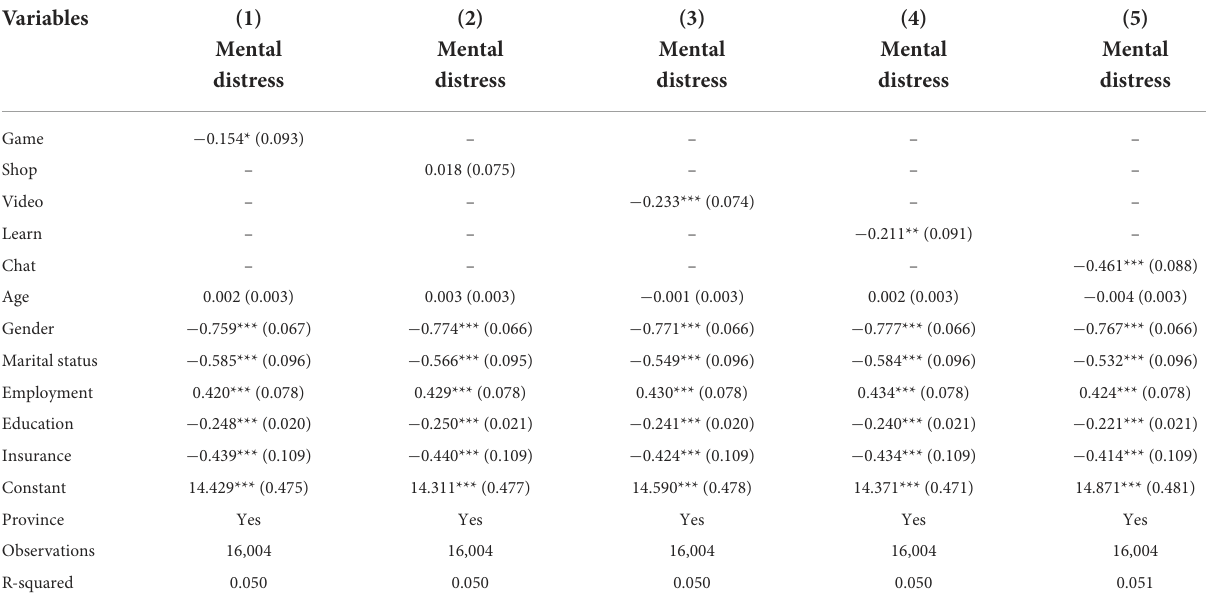
TABLE 8 Result of regressions based on the different purposes of mobile Internet